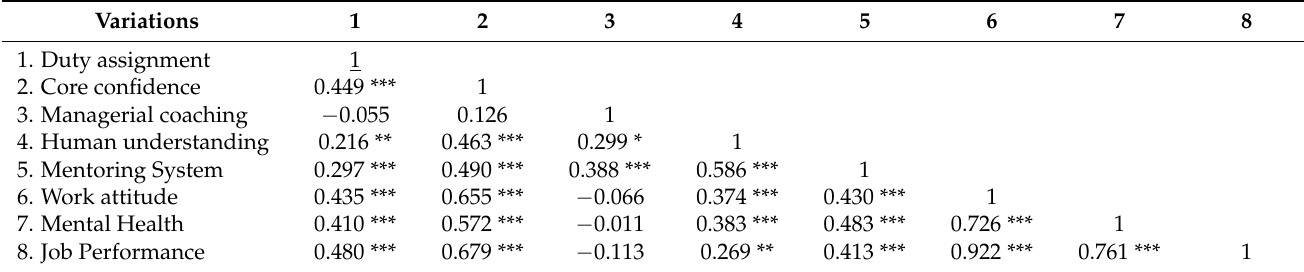
Table 4. Verification of correlation